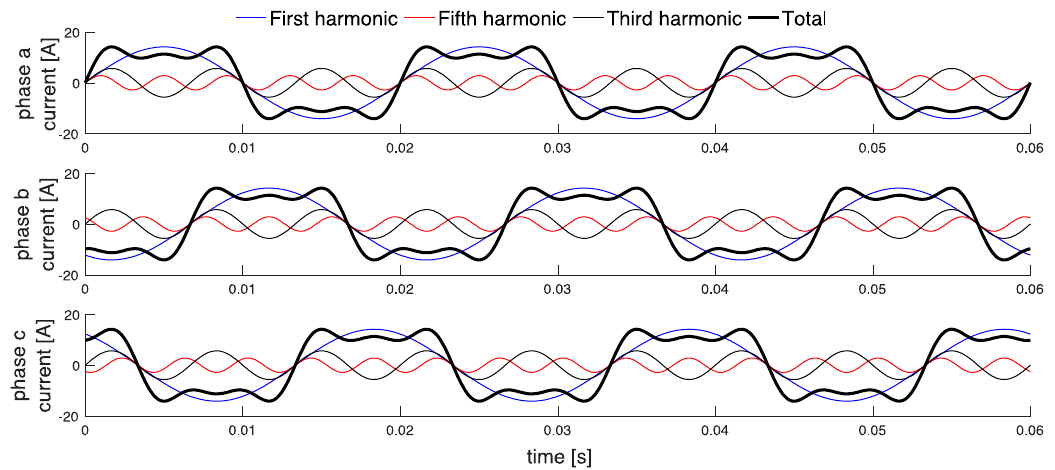
Figure 1. Waveforms of the three harmonic currents and of their sum (total).